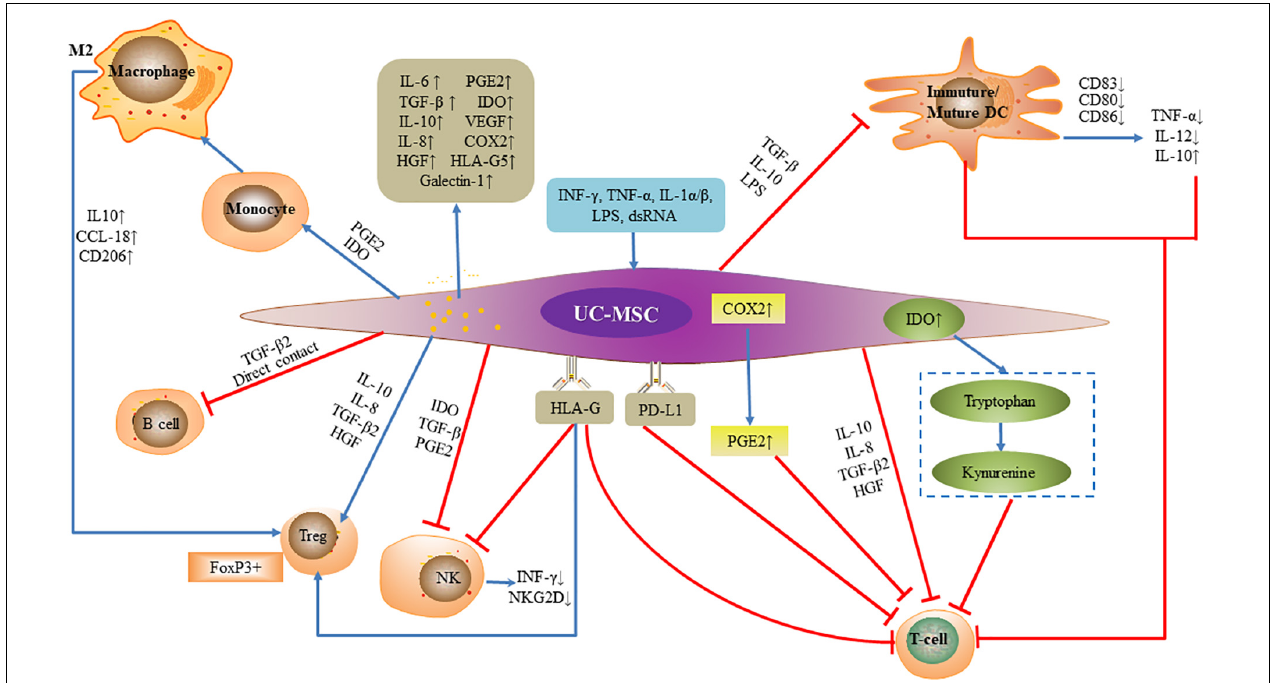
FIGURE 2 | Immunomodulatory function of umbilical cord mesenchymal stem cells. Under the license of INF- γ , TNF- α , IL-1 α / β , LPS, and dsRNA, umbilical cord mesenchymal stem cells secrete inflammatory factors and alter the expression of surface antigen to exert effects. Umbilical cord mesenchymal stem cells inhibit the proliferation and cytotoxicity of activated T lymphocytes, and secretion of inflammatory factors, inhibit B lymphocytes and secretion of immunoglobulins, inhibit NK cell killing activity and proliferation, and inhibit differentiation of monocytes into DCs achieving tolerogenic phenotype. Umbilical cord mesenchymal stem cells promote regulatory T